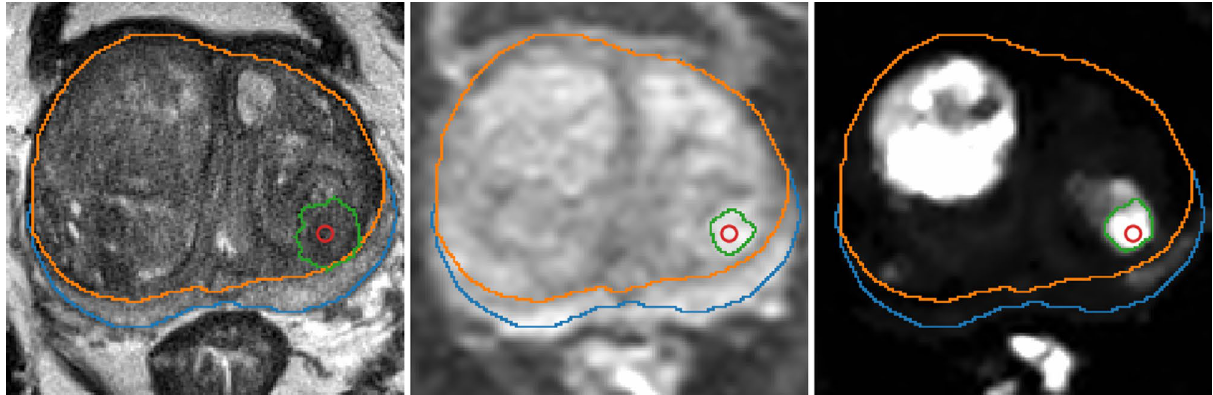
Figure 4. Automatic lesion segmentation for a ProstateX patient in sequences (from left to right: T2, b800 and K trans ) before combining them. Prostate zonal segmentation and the original lesion position (in red) are shown for reference.